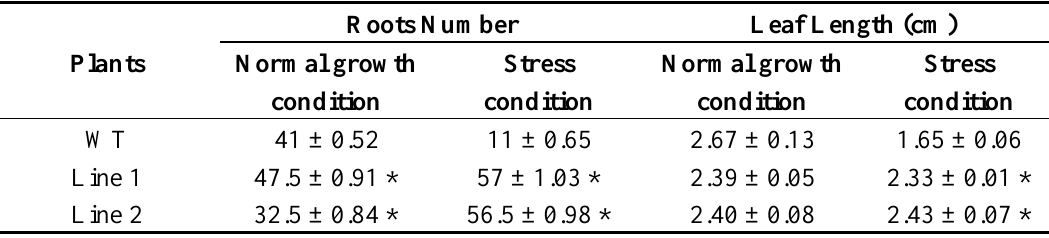
Table 1. Comparison of growth between TaLEA1 transgenic and WT plants. The 35S::LEA lines and wild-type were grown in 1/2MS rooting medium with 100 μM CdCl for 20